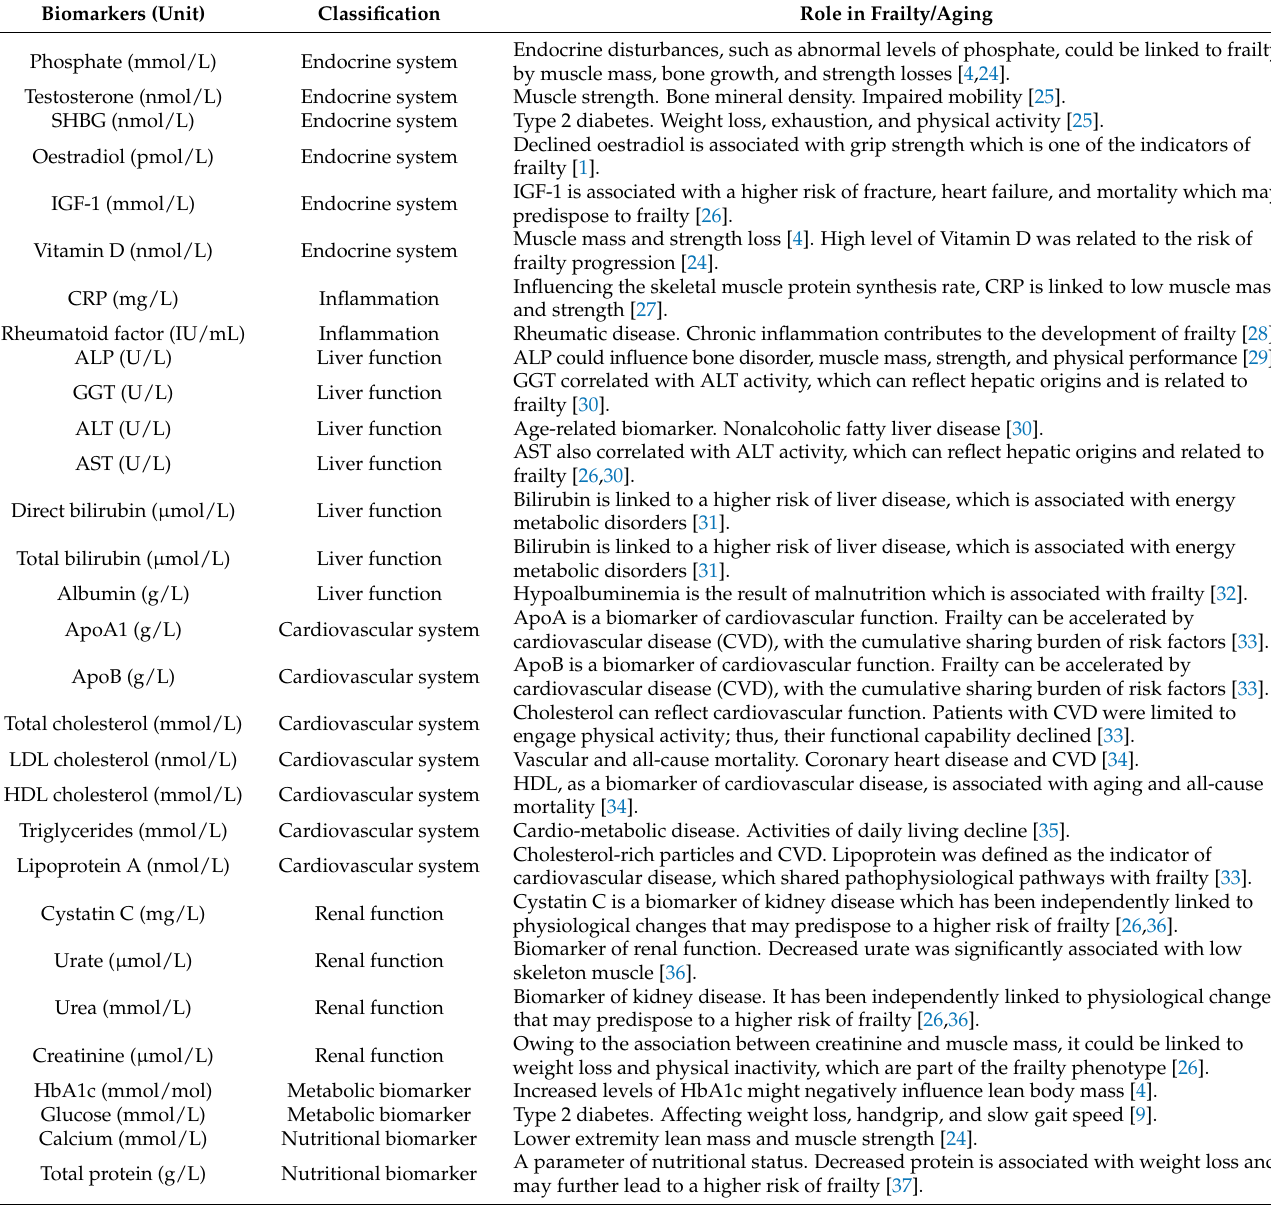
Table 1. Biomarkers and their roles in